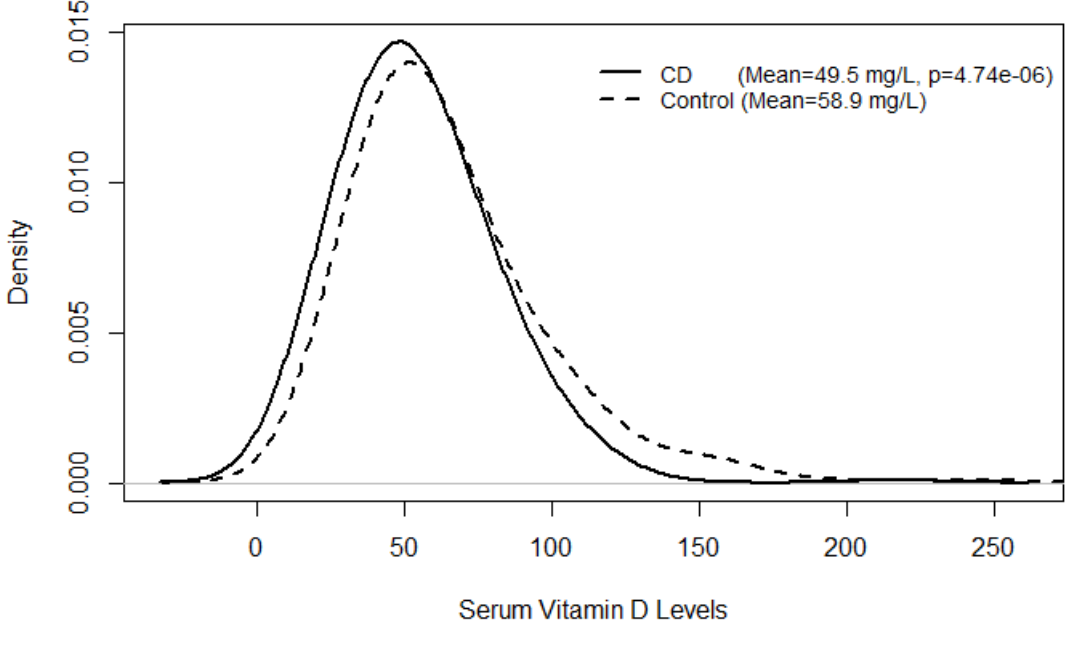
Figure 1. A density plot comparing serum vitamin D levels between Crohn’s Disease patients and controls.